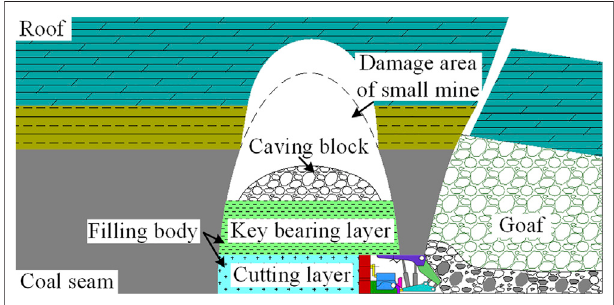
FIGURE 3 | Schematic of layered fi lling for damage zone treatment.